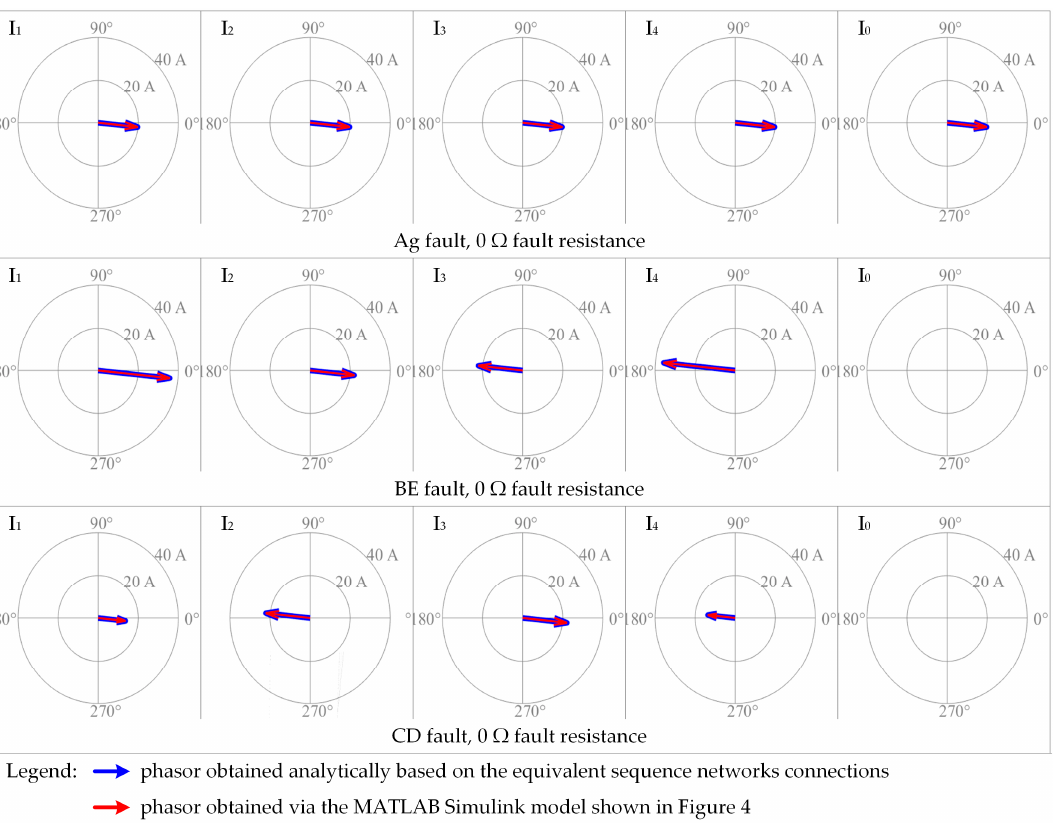
Figure 5. Symmetrical components of current, denoted I 1 , I 2 , I 3 , I 4 , I 0 , during Ag, BE, and CD faults for R f = 0 Ω .